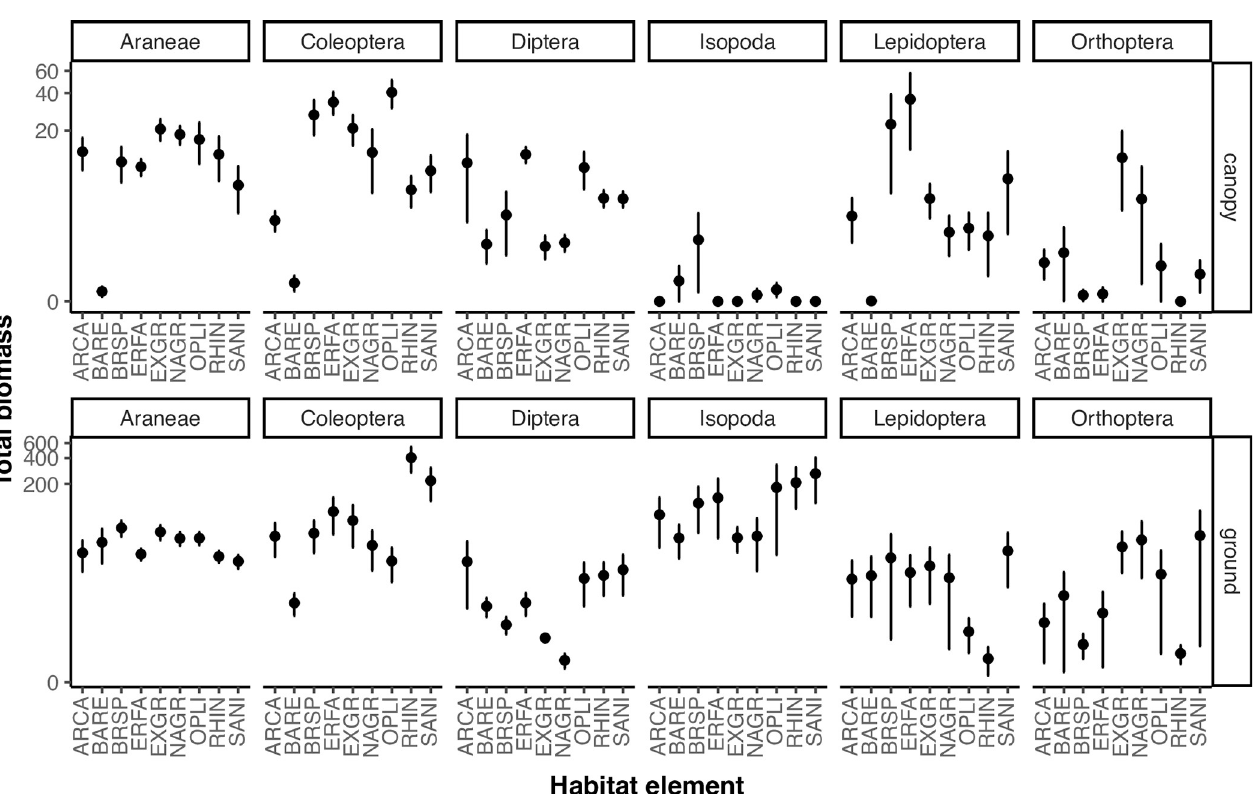
Fig 4. Mean biomass (mg ± SE) of prey orders from field-sampled arthropods across focal habitat elements in the canopy (top row) and on the ground (bottom row). Arthropods were sampled from native plant species; Artemisia californica (ARCA), Eriogonum fasciculatum (ERFA), O . littoralis (OPLI), Rhus integrifolia (RHIN), Sambucus nigra (SANI), and grasses (NAGR).; non-native Brassica nigra (BRSP) and grasses (EXGR); and bare ground (BARE). Bare ground was sampled by both pitfall sampling and vacuum collecting any arthropod observed within 0.5 m of the pitfall trap, referred to as canopy sampling above for consistency with plant